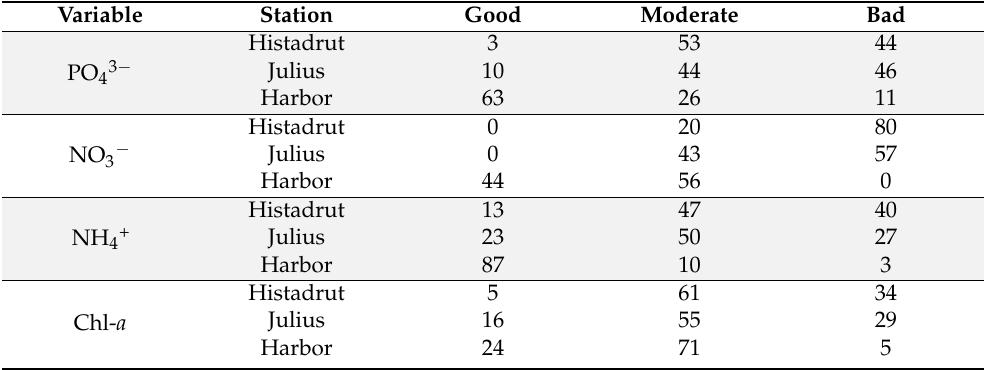
Table 3. The percent of nutrients and chl- a measured along the Kishon River Estuary in 2002–2021 falls within each of the status categories adopted in this study (Table 2). Variable Station Good Moderate Bad